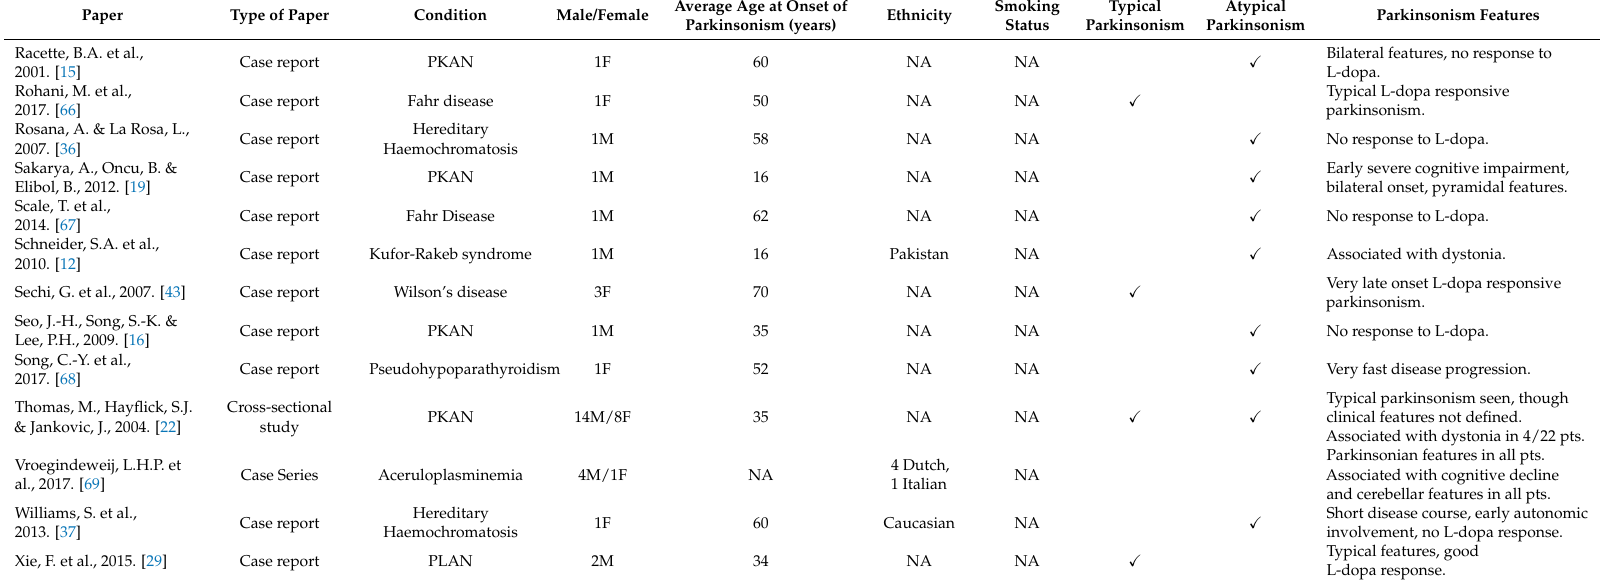
Williams, S. et al., Short disease course, early autonomic